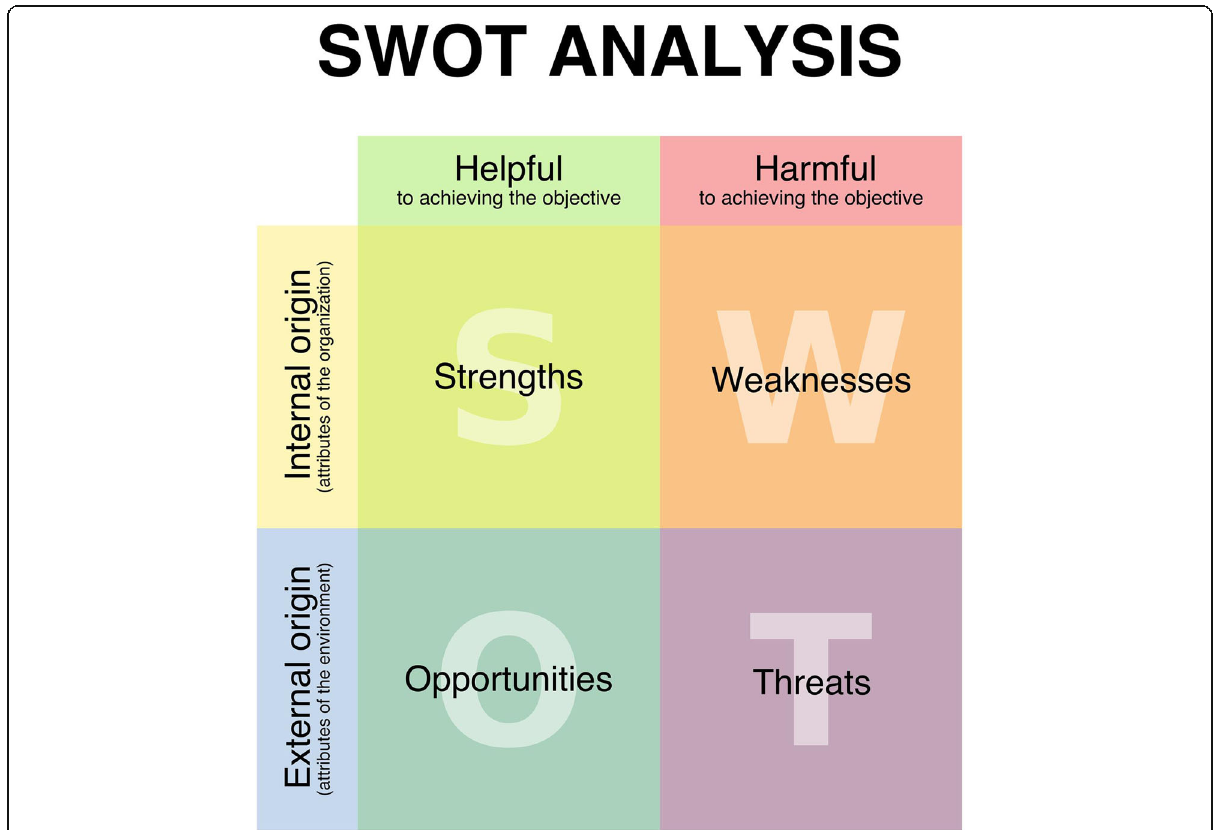
Fig. 4 SWOT analysis graphic (Source: Wikimedia Commons)